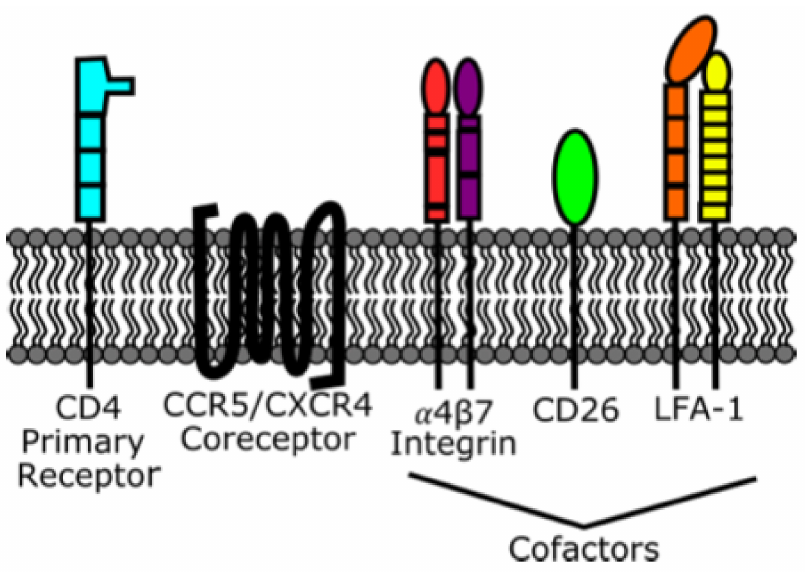
Figure 5. Receptors and coreceptors on CD4 T cells. Tropism of HIV is determined by receptors and coreceptors that allow for binding to the cell surface. LFA-1: lymphocyte-function-associated antigen. Adapted from